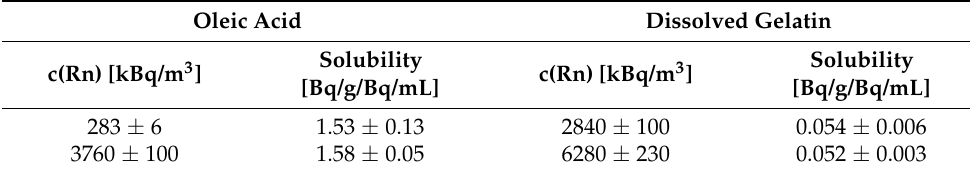
Table 2. Comparison of solubility data obtained by the exposure of samples to different radon activity concentrations (c(Rn)) and subsequent normalization to the according activity concentrations.